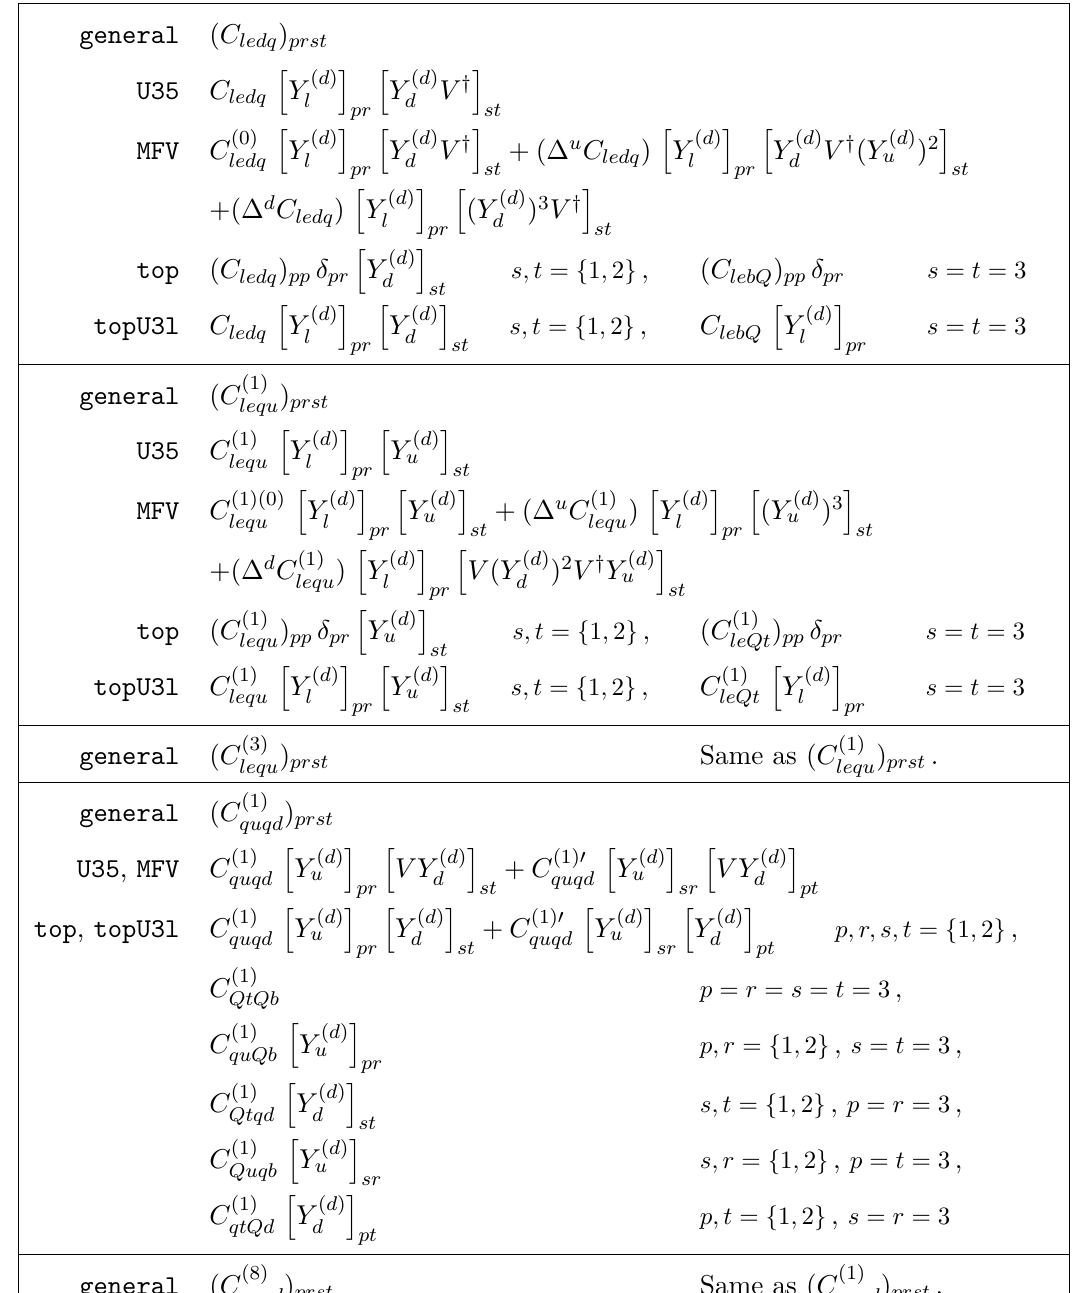
Table 15 . Conversion table among the 5 flavor assumptions considered, for the operators in L (8 d )